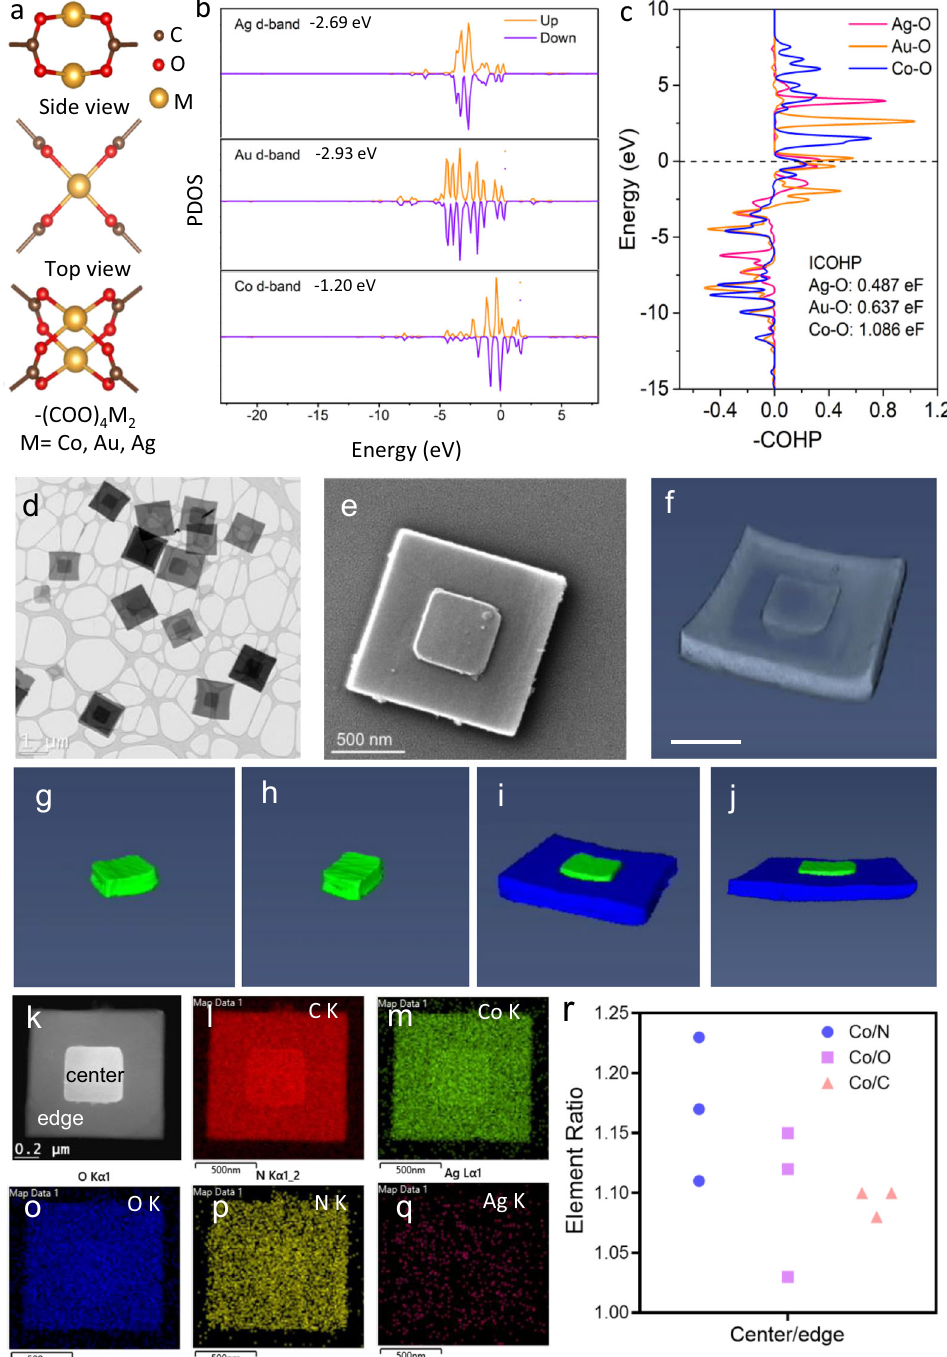
Fig. 1 Structural and elemental analysis of Co-MOF-3 nanostacks. a Schematic illustrations of – (COO) 4 M 2 (M = Co, Au, Ag). b PDOS of d -band of M in – (COO) = 0. c COHP bonding analysis of M – O interactions in 4 M 2 (up: spin up, down: spin down) and corresponding caculated d-band center values. Ef – (COO) = 0. The unit is eV/f.u.(eF), standing for eV per formula unit. ICOHP represents the intensities of COHP. d A typical TEM image of Co- 4 M 2 . Ef MOF-3. e The SEM image of Co-MOF-3. f 3D TEM image of Co-MOF-3 nanostack and 3D electron tomography reconstruction model of the small squared plate ( g , h ) and large squared plate in Co-MOF-3 ( i , j ) shown in f . Scale bar, 500 nm. k HAADF image of Co-MOF-3 and the corresponding EDS elemental mapping images of l C, m Co, o O, p N and q Ag in Co-MOF-3. r EDS peak-area ratios of K series for Co/N, Co/O, and Co/C between the central (center) and the peripheral area (edge) of nanoplates implies that the lateral sizes were much larger than the either heterojunctions or homojucntions, since it is still very heights of both large and small nanoplates (Supplementary challenging to control the relative orientations of the two Fig. 11). AFM (Supplementary Fig. 12) and SEM (Supplementary components at their interface. An AFM image of Co-MOF-3 Fig. 13) images of a single Co-MOF-3 particle with the small